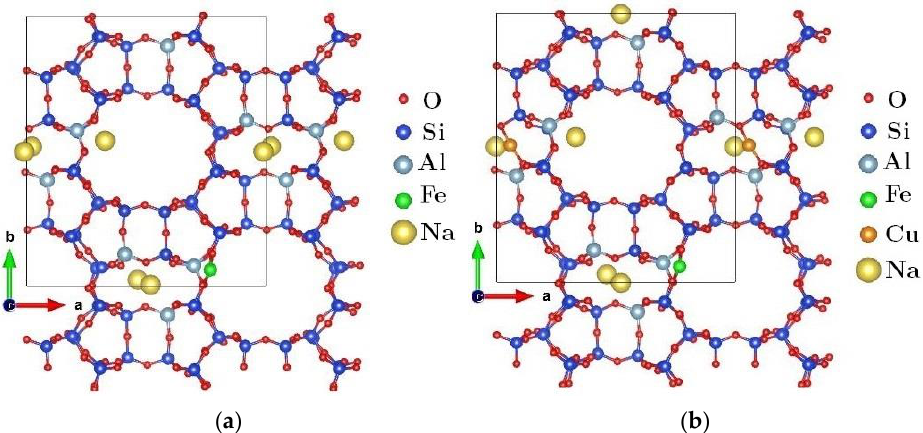
Figure 4. Minimal energy configurations for sodic mordenite zeolite with a Si/Al = 7 ratio and: ( a ) one Fe atom and ( b ) one Fe and one Cu atom by unit cell. In both cases, the unit cell (delimited by the black square box) was extended to better appreciate atom distribution.